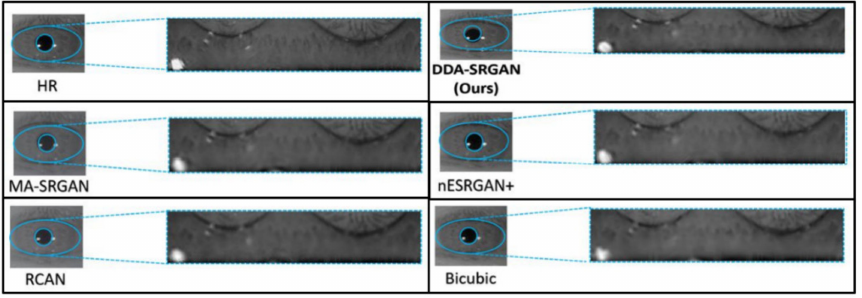
Figure 16. Visual comparison of the super-resolved image of “Rcls6_10” from CASIA